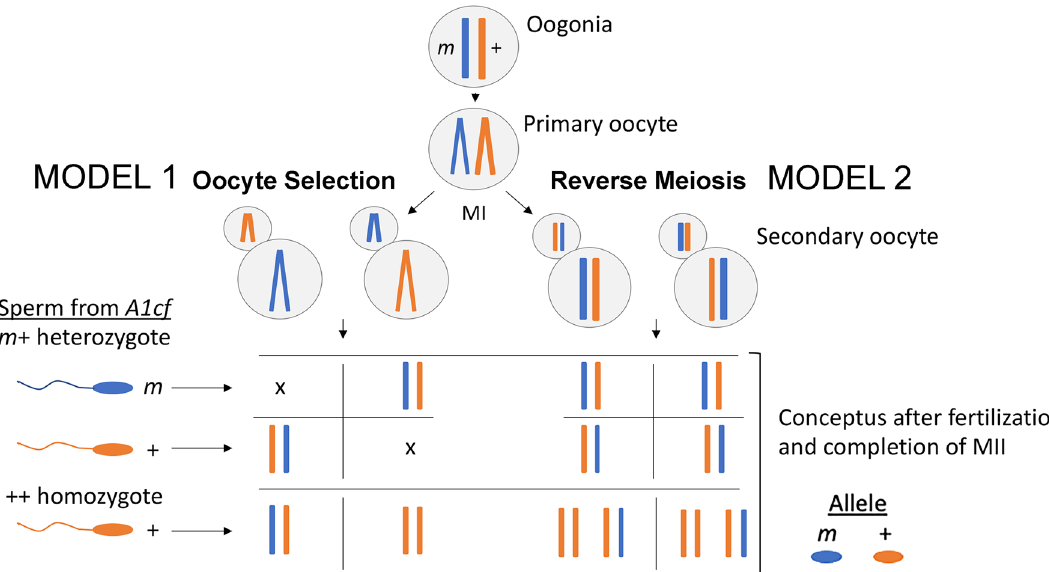
Figure 6. Two models for Biased Fertilization. Two models for putative effects of sperm and oocyte genotype on oocyte selection and meiosis are shown. According to the Oocyte Selection Model, sperm from m + males preferentially or perhaps exclusively join with genetically heterologous ++ oocytes (or ++ sperm with m + oocytes). By contrast, with the Reversed Meiosis Model, the genetics of fertilizing sperm determines which chromatid remains in the oocyte and which goes to the second polar body. In A1cf mice, the preference is to retain the chromatid with the opposite allele to that sperm brings so that heterozygous embryos predominate. Gametes with recombinant chromosomes are not